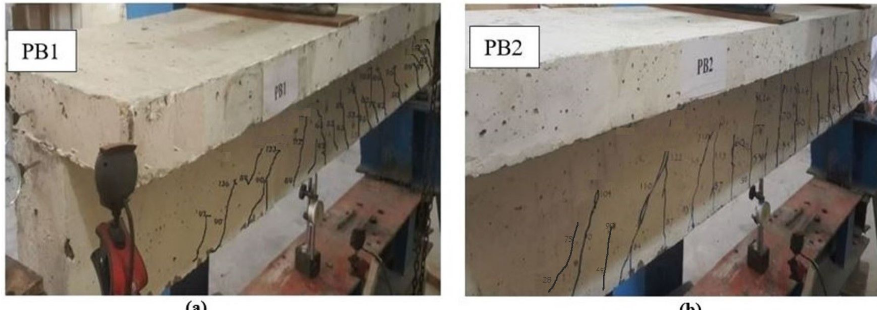
Figure 7: Cracking patterns of reference beams: (a) PB1; (b) PB2